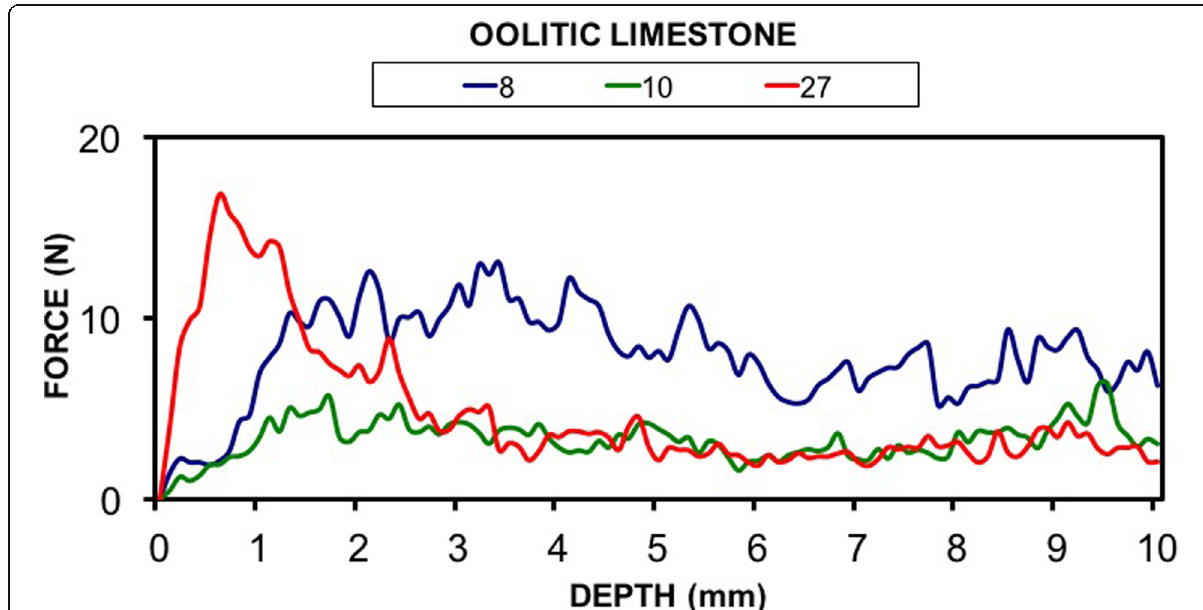
Fig. 7 Profiles of the average values of demanded drilling forces versus the drilled depth from the surface to the interior of the material for representative blocks of oolitic limestones tested in situ ; block 27 was located in the unprotected area of the monument and it was exposed to the exterior environmental conditions, while blocks 8 and 10 were located in the sheltered areas of the site